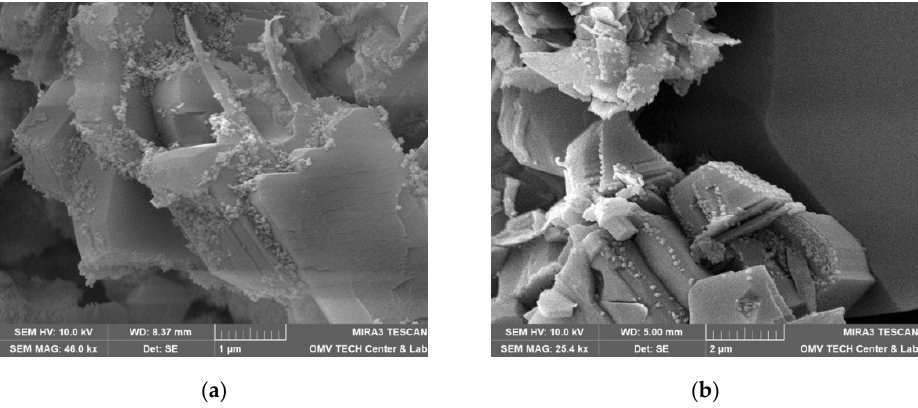
Figure 18. Scanning electron microscope (SEM) images measured for the core material used in this